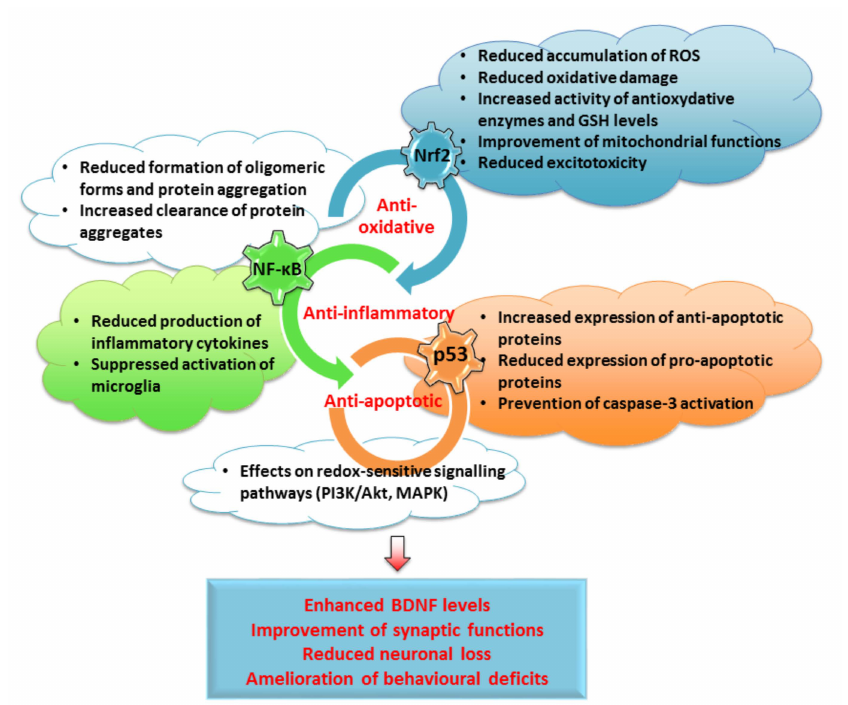
Figure 7. Molecular and cellular mechanisms underlying the anti-oxidative, anti-inflammatory and anti-apoptotic effects of